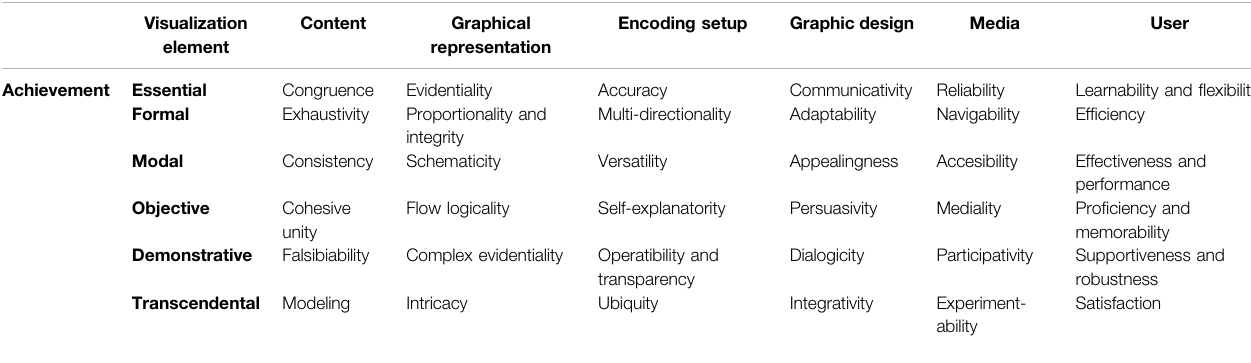
TABLE 3 | Dimensional taxonomy of data visualization: properties or conditions of data